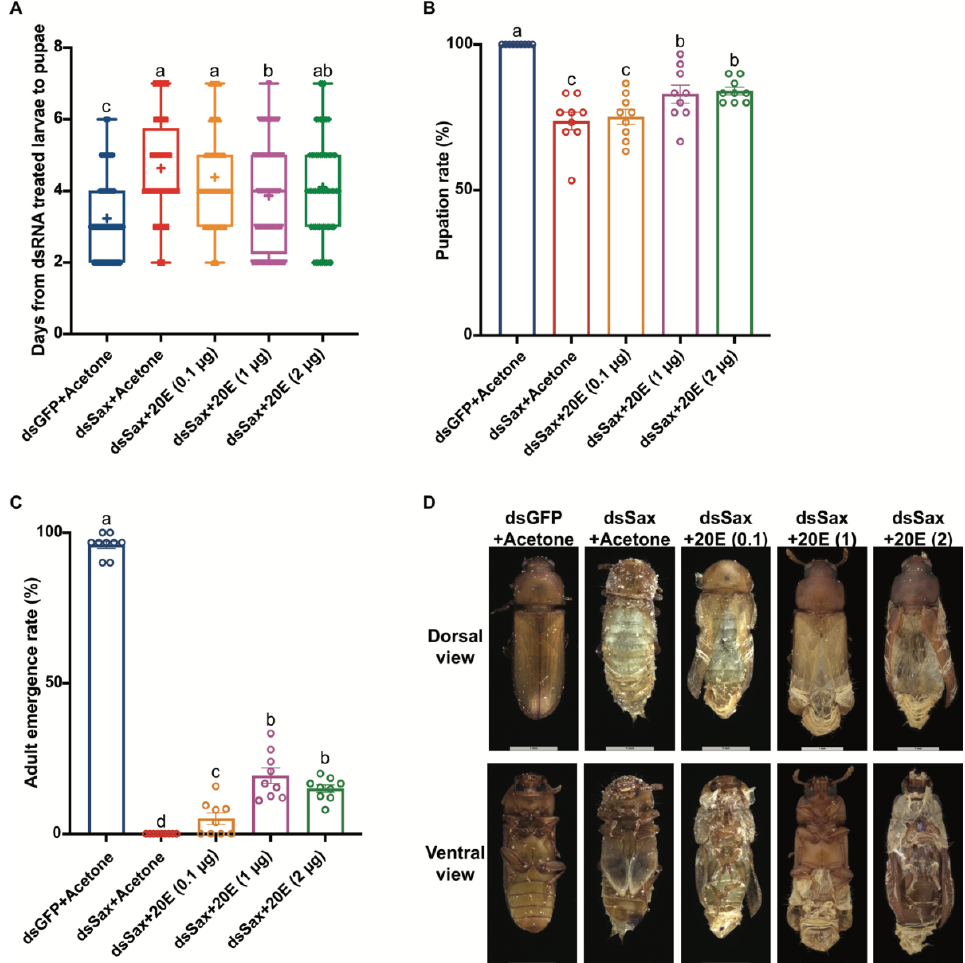
Figure 8. Effects of 20E application on the larval-pupal-adult development of T. castaneum post Sax RNAi. ( A ) Days from dsRNA treated 19-day larvae to newly formed pupae from the acetone or different doses of 20E (0.1, 1 and 2 μ g/larva) applicated groups 24 h post 100ng/larva dsGFP or dsSax treatment. ( B ) Pupation rate in the acetone or different doses of 20E (0.1, 1 and 2 μ g/larva) applicated groups 24 h post 100ng/larva dsGFP or dsSax treatment. ( C ) Adult emergence rate in the acetone or different doses of 20E (0.1, 1 and 2 μ g/larva) applicated groups 24 h post 100ng/larva dsGFP or dsSax treatment. ( D ) The phenotype of adults or failed emergence of adults from acetone or different doses of 20E (0.1, 1 and 2 μ g/larva) applicated groups 24 h post 100ng/larva dsGFP or dsSax treatment. Different letters on the bars indicate that the means ± SEM are significantly different among treatments by t -test.